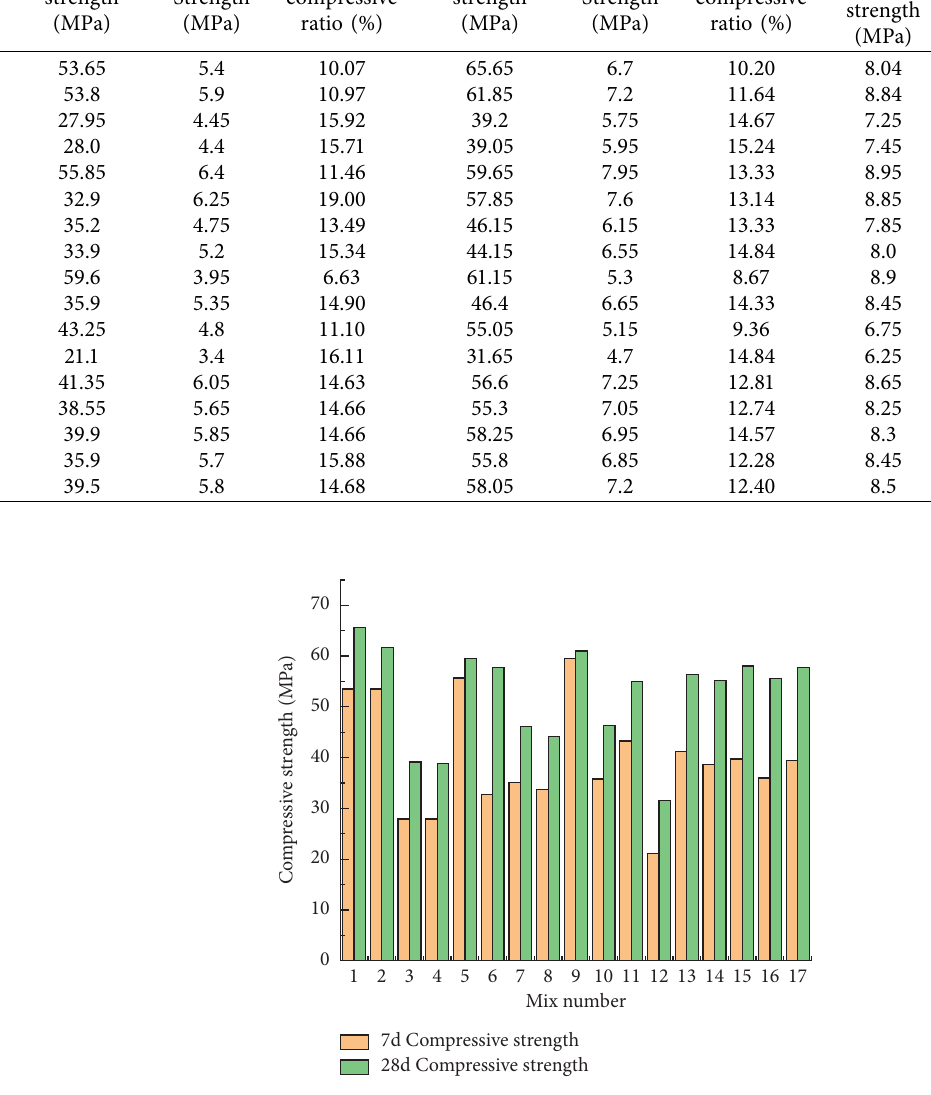
Figure 4: Compressive strength of different mix design and different